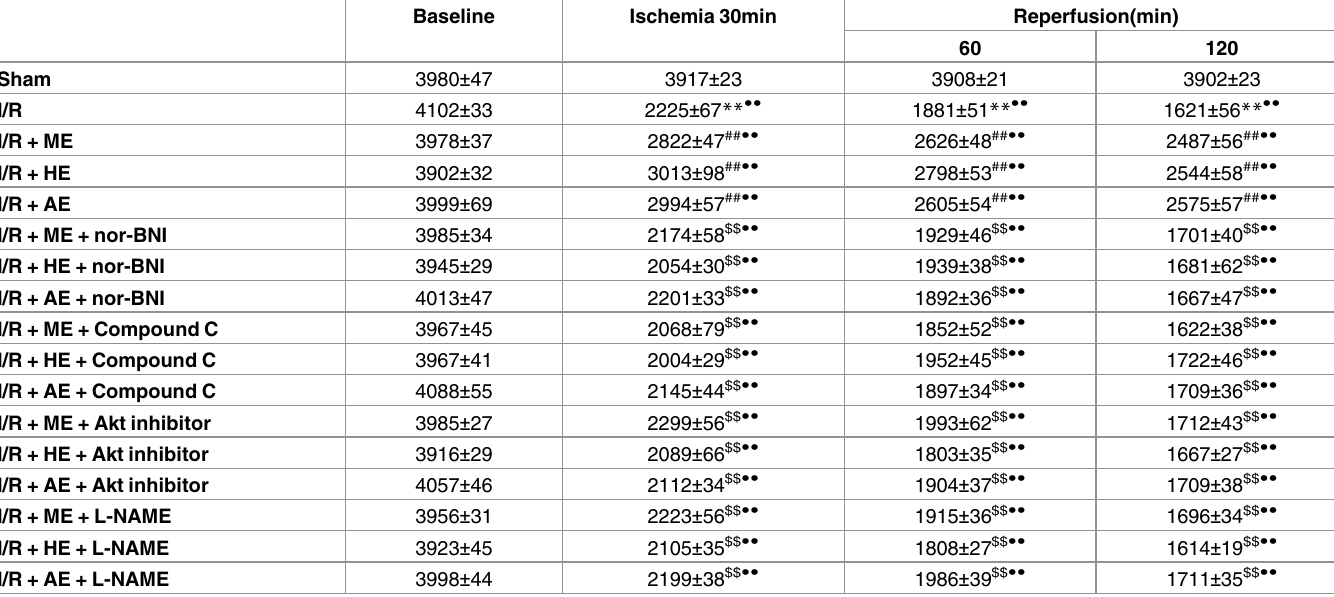
Table 3. Changes in dP/dtmax (mm Hg/s) during myocardial I/R.